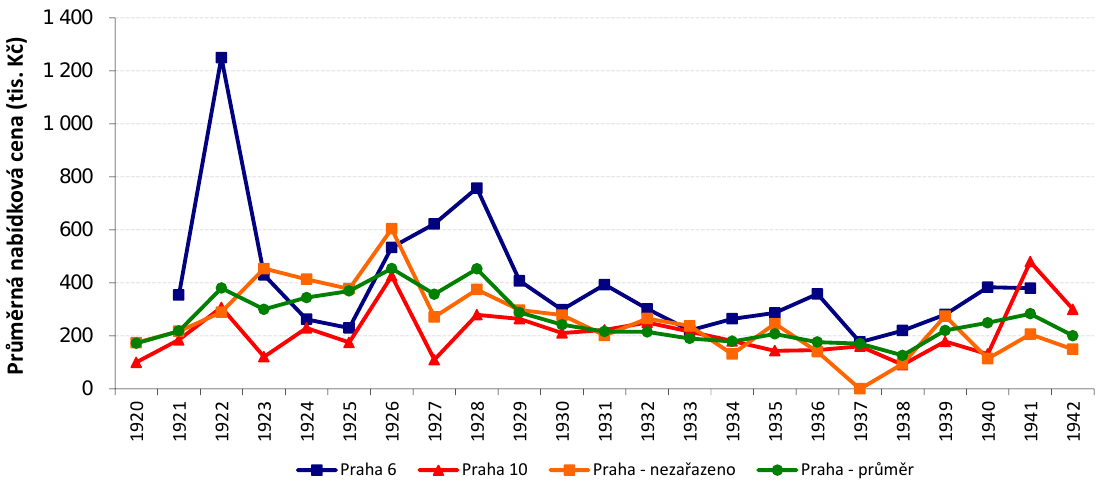
Obrázek 10: Průměrná nabídková cena rodinného domu v Praze 2, 4, 5 a průměr za celou Prahu.